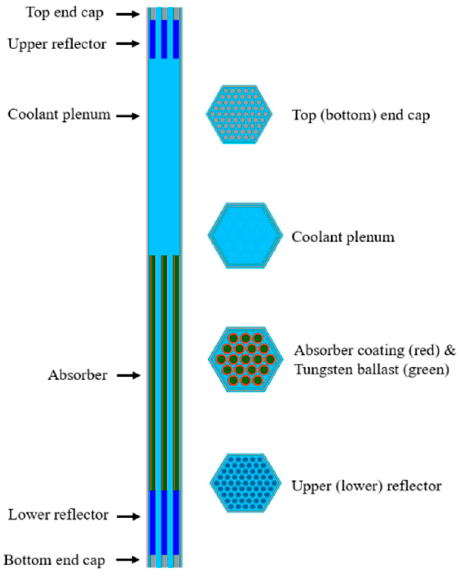
Figure 3. Control assembly configuration.